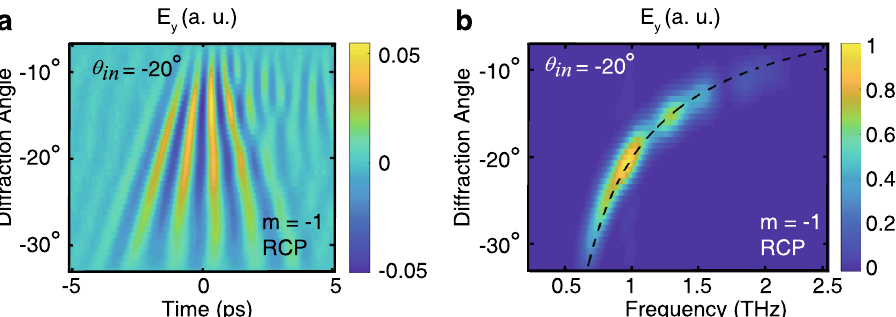
Fig. 3 Full spatiotemporal representation of one spin-state of THz wave. a Measurement of the full E y , m = − 1 (RCP) fi ve-cycle diffraction order after pumping at an oblique angle of θ in = − 20°. b Frequency spectrum of the circularly polarized THz waves, with a spectral range from ~0.6 THz to over 2.0 THz. The dashed line shows the calculated Raman-Nath